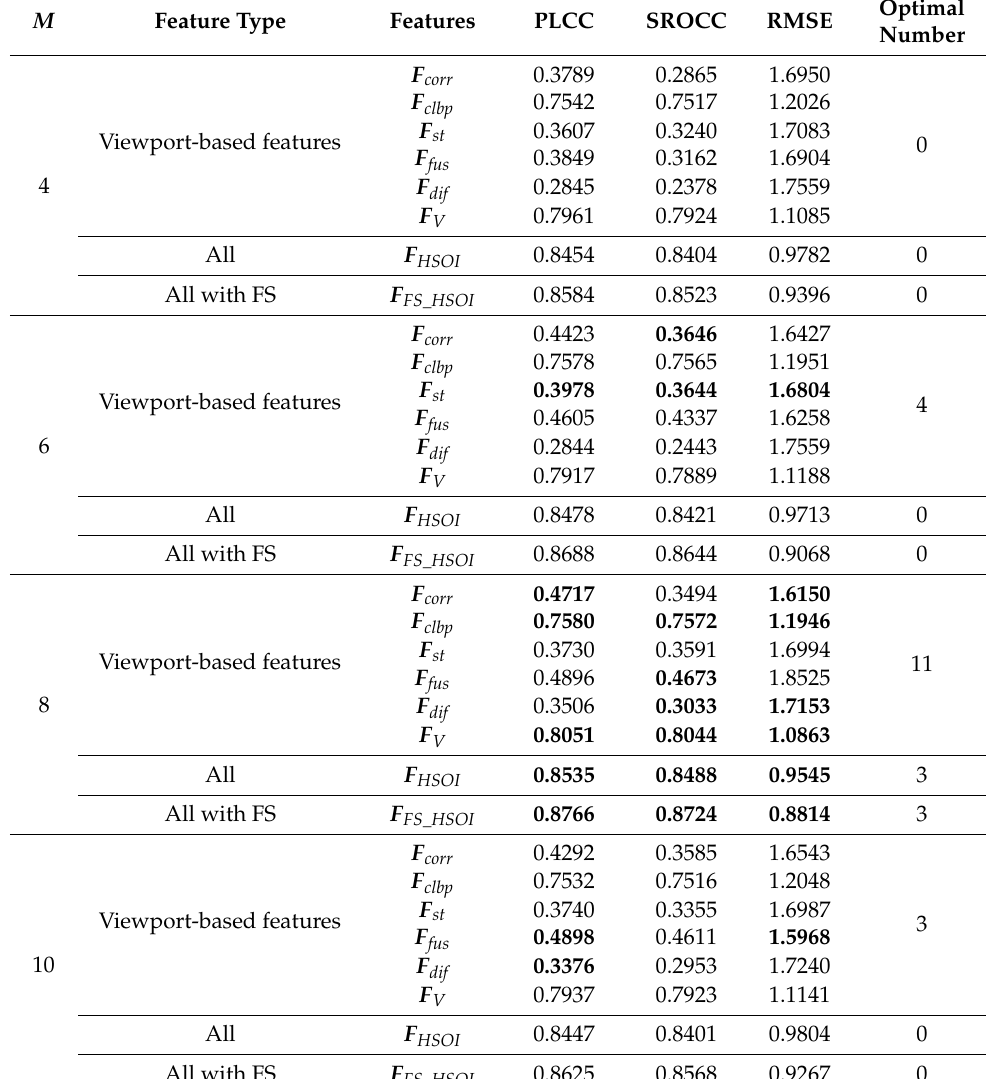
Table 9. Objective quality assessment results with respect to different M